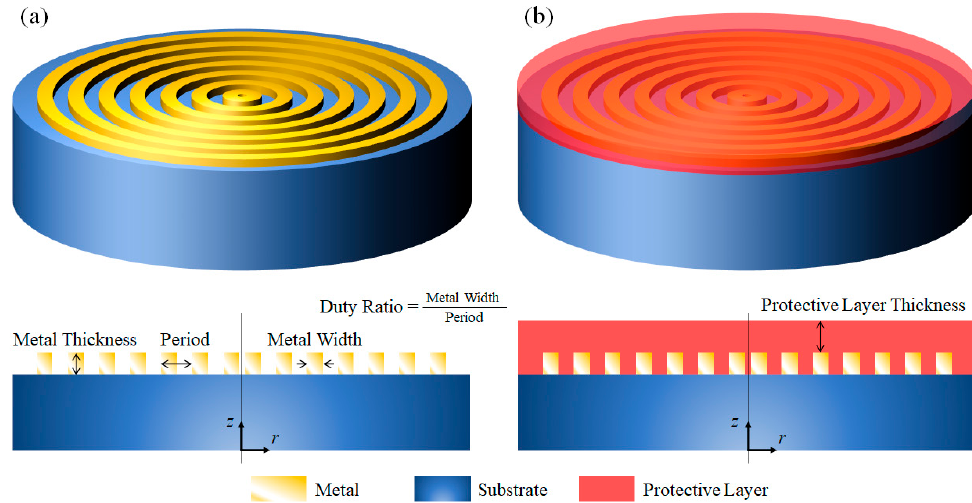
Figure 1. ( a ) Configuration of the structure of MSCRA without protective layer. ( b ) Configuration of the protective layer applied MSCRA.